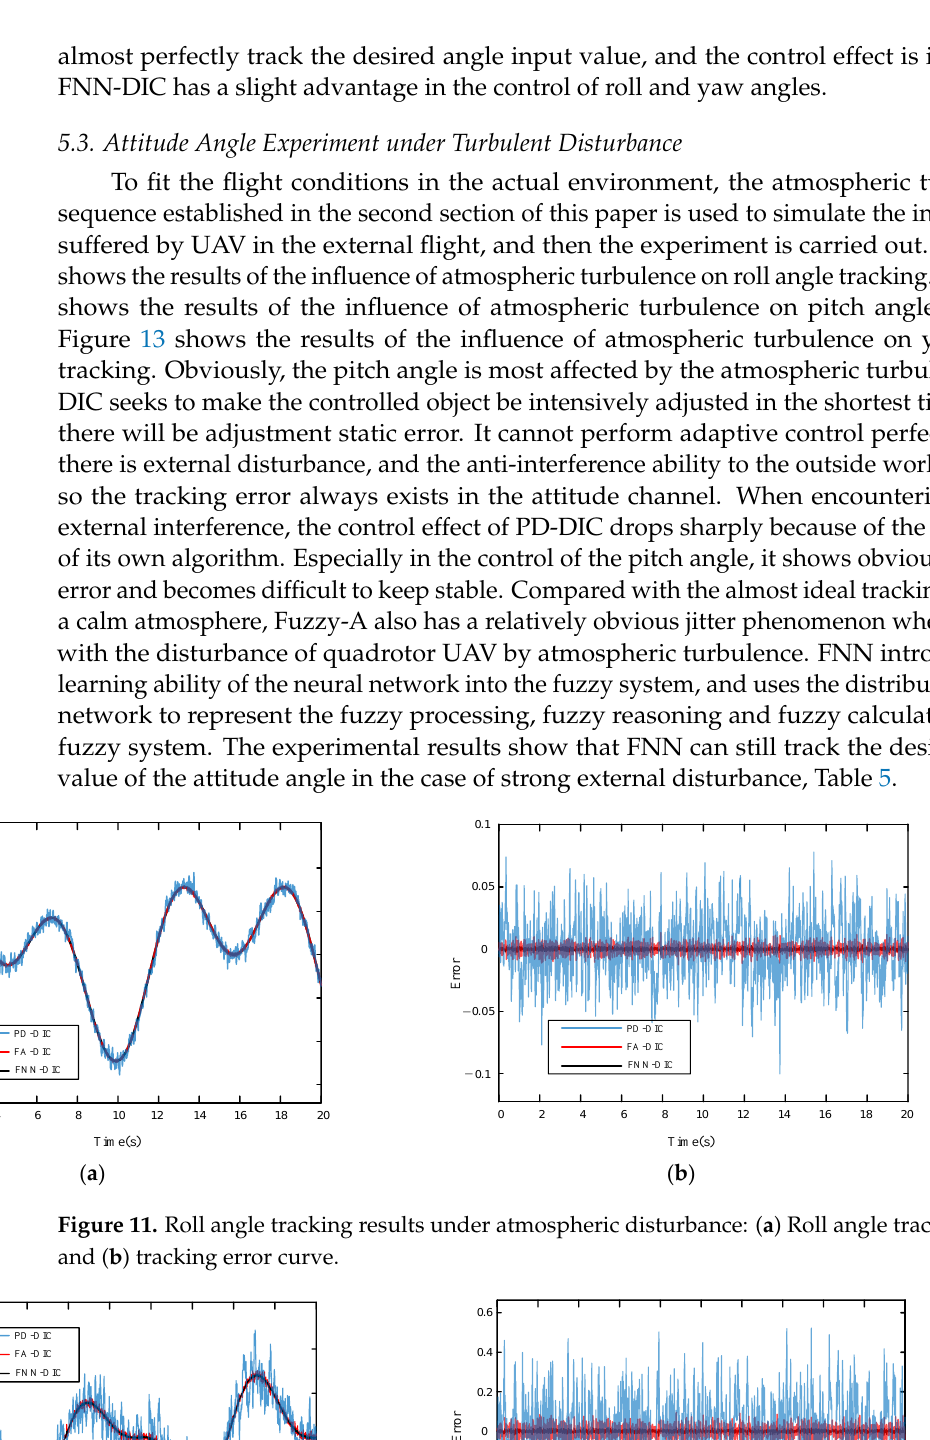
Figure 10. The results of the yaw angle trajectory tracking. ( a ) Yaw angle tracking track, and ( b ) yaw angle tracking error.